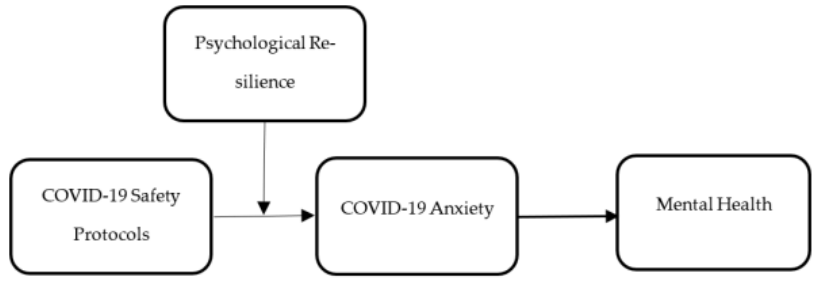
Figure 1. Theoretical framework.